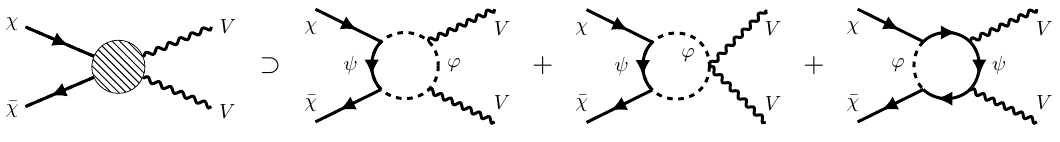
Figure 8 . Representative diagrams for loop-induced dark matter annihilation to electrically neutral SM gauge bosons, χ ¯ χ → V V